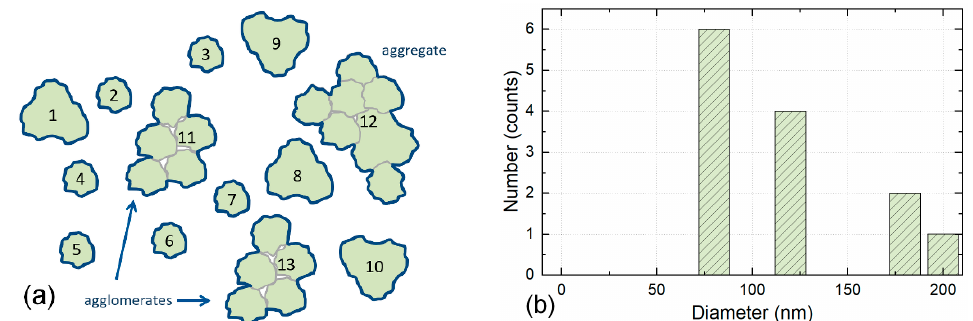
Figure 3. Illustration of Counting Rule 2. ( a ) The particles 1 to 10 are counted as individual particles—as in CR1. The agglomerates 11 and 13 and the aggregate 12 are counted each as one particle. This results in a total count of 13 particles. ( b ) The size of the agglomerates and the aggregate is 180 nm and 200 nm, respectively. Note the shift of the PSD to higher values in comparison to CR1. The height of the four columns in the histogram reflects the number of particles of the four sizes 80 nm (6 particles), 120 nm (4 particles), 180 nm (2 particles) and 200 nm (1 particle). The width of the columns has no quantitative relevance and is only illustrative.